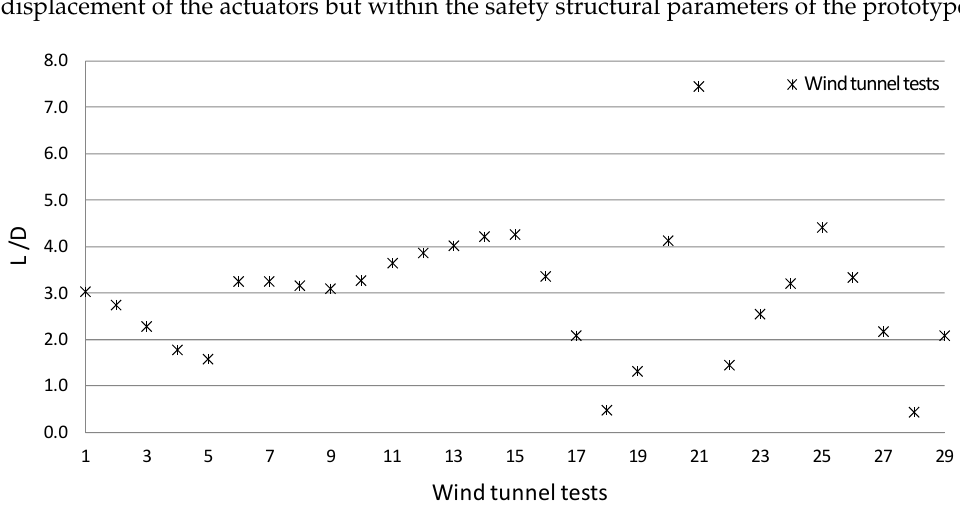
Figure 27. Lift-to-drag wind tunnel results of the adaptive wing prototype at cruising speed of 30.1 m/s. The low drag production and high lift-to-drag ratio (efficiency factor) of the adaptive wing will translate into a reduction in fuel consumption and an increase in the S45 effective range. Adaptive wing systems for UAVs are a promising technology and have become a major solution for multipurpose flight operations because they allow the aerodynamic potential of UAVs to be optimized by adapting the wing to several flight conditions, and they also result in climate improvement by fuel consumption